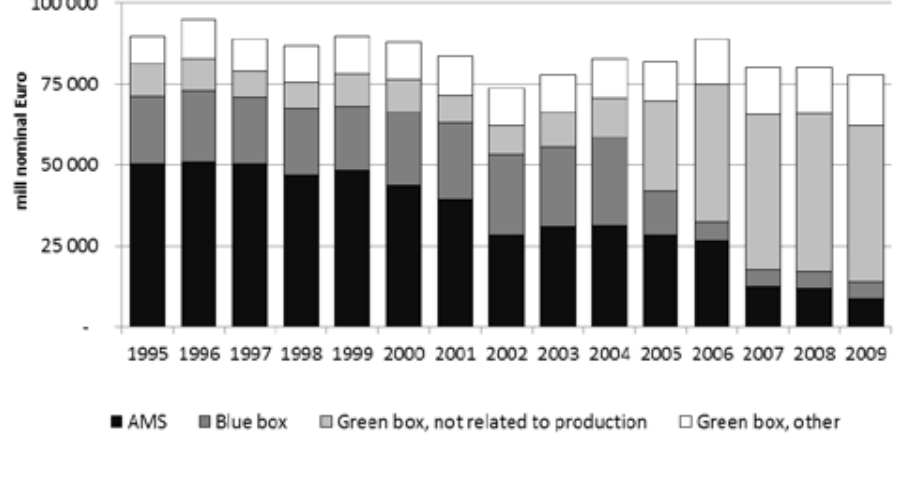
Figure 1. Support to agricultural producers in the European Union as measured by the WTO by type of support, 1995-2009 (mill